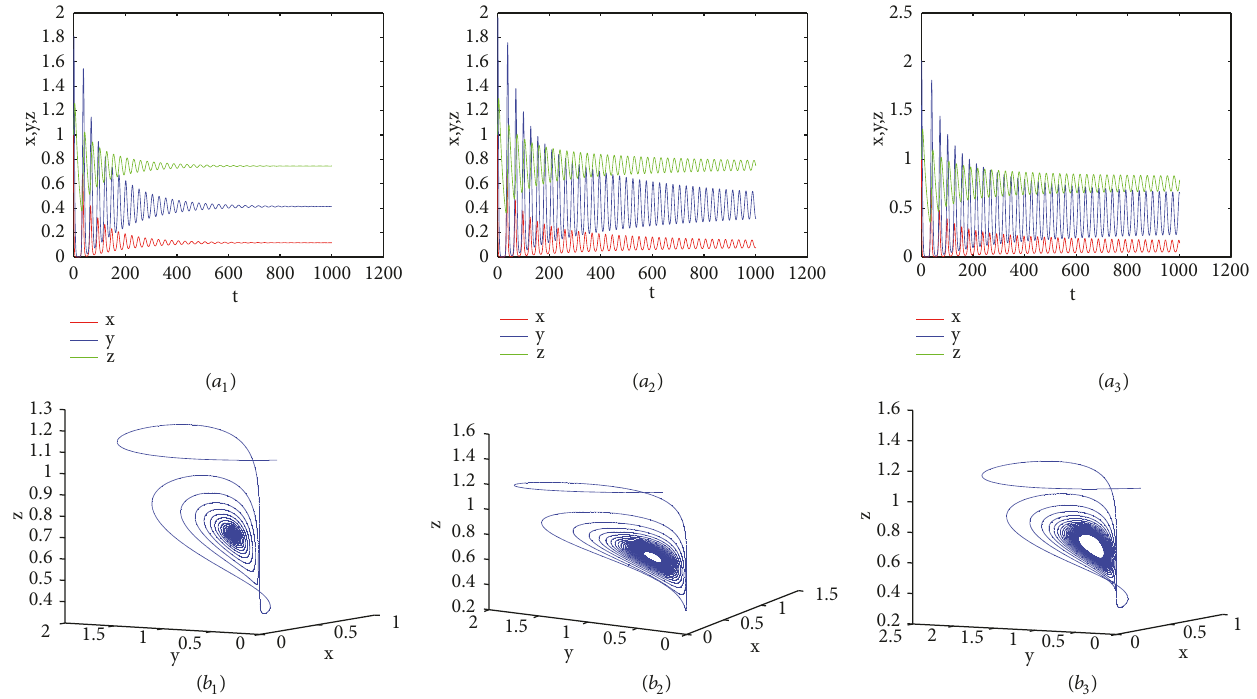
Figure 8: Time series plots and the three-dimensional space graphs of Experiment 5 with different parameters: (𝑎 1 ) and (𝑏 1 ) 𝑐 = 1.4 ; (𝑎 2 ) and (𝑏 ) 𝑐 = 1.575 ; (𝑎 ) and (𝑏 ) 𝑐 = 1.62 2 3 3